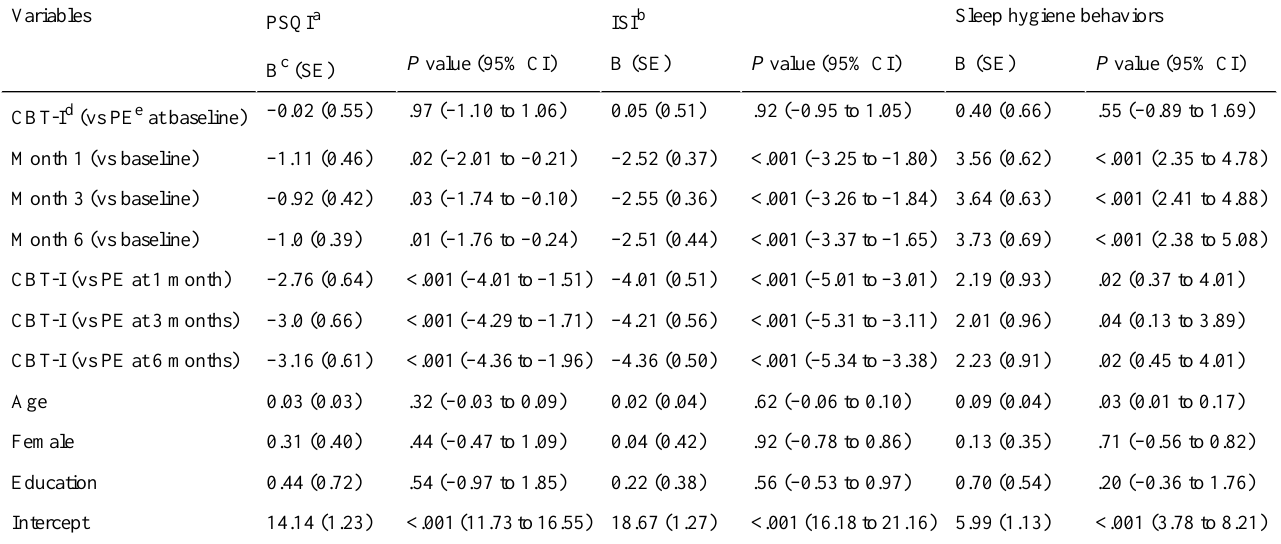
Table 4. Results of the linear mixed models for primary